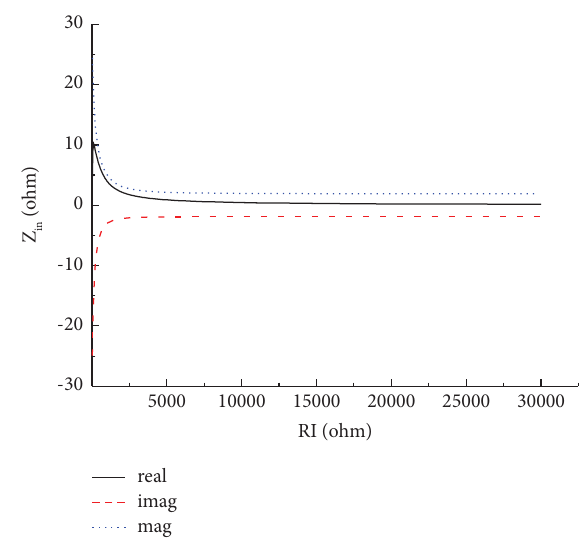
Figure 32: Te input impedance of the modifed circuit shown in Figure 31.